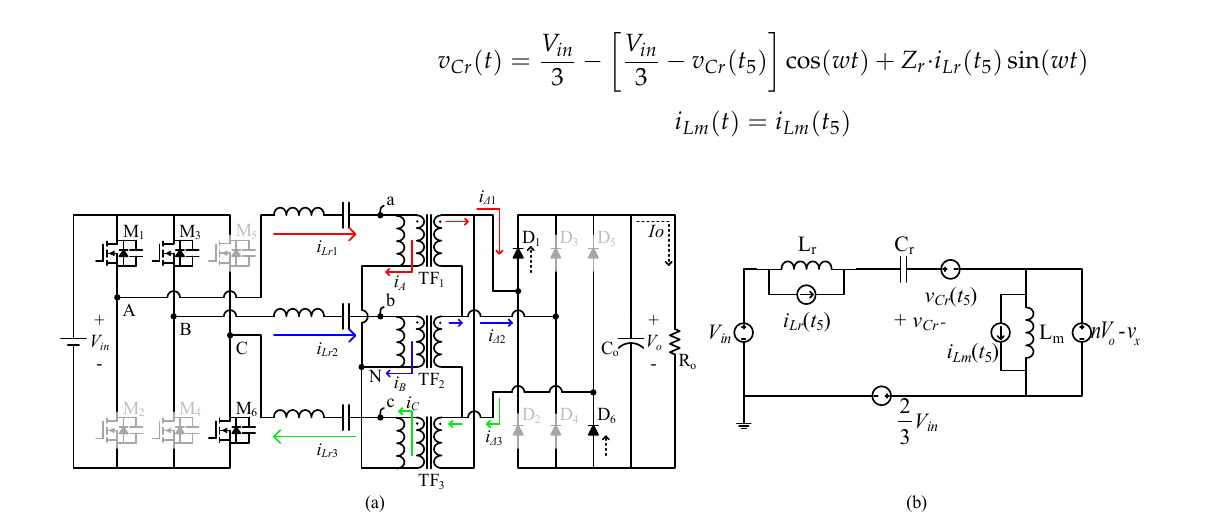
Figure 9. ( a ) Circuit station at Stage 6 ( b ) Equivalent circuit at Stage 6.